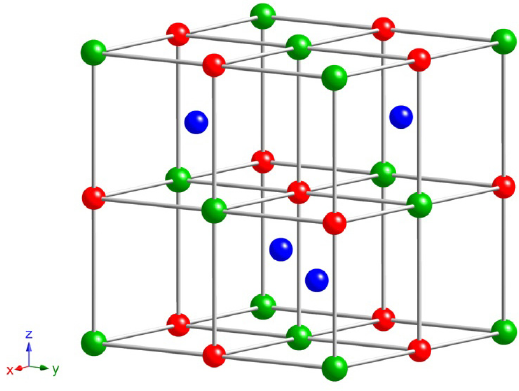
Figure 2. The crystal structure of a typical Half-Heusler (HH) compound